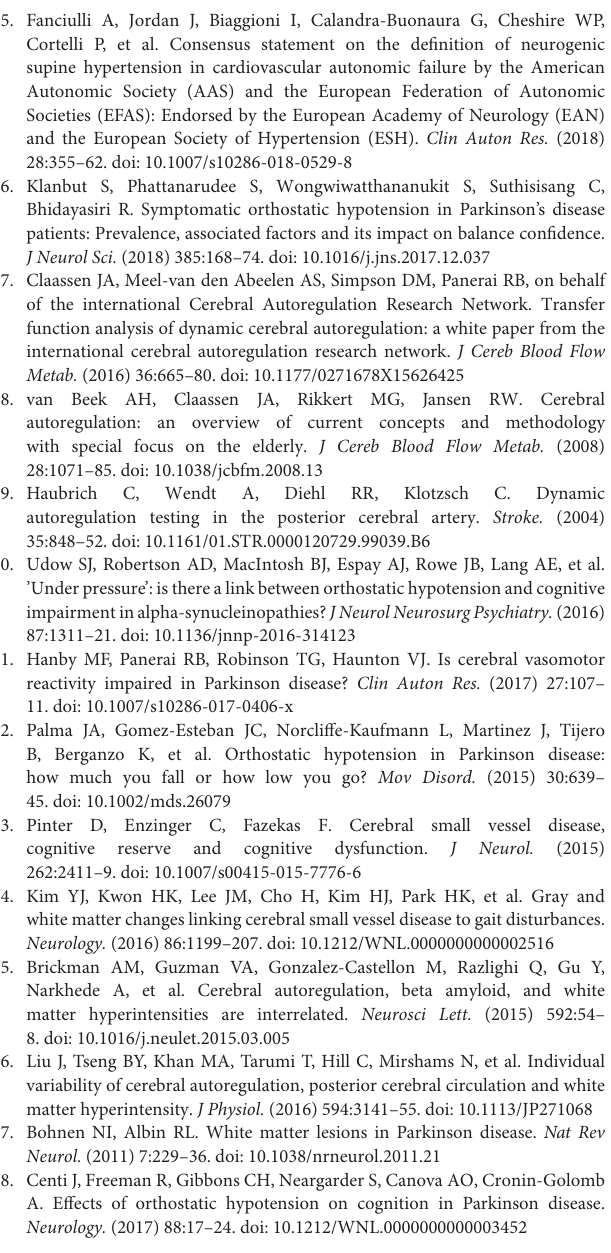
Supplementary Figure 2 | Mean arterial pressure (MAP) and mean velocity (MV) changes during postural changes between Parkinson’s disease with orthostatic hypotension (PD-OH) and Parkinson’s disease without orthostatic hypotension (PD-NOR) groups. (A) MAP changes at each moment during the active standing test (AST) between OH groups. (B) Changes in MV of MCA at each moment during the AST between OH groups. MAP, mean arterial pressure; MV, mean velocity; PD-OH, Parkinson’s disease with orthostatic hypotension; PD-NOR, Parkinson’s disease without orthostatic hypotension; MCA, middle cerebral artery. Supplementary Table 1 | Blood pressure and cerebral blood flow velocity in patients with or without OH. Supplementary Table 2 | MAP cutoff value for detecting symptomatic